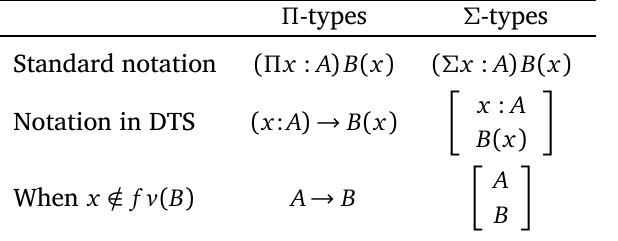
Figure 1: Notation for (cid:5) -types and (cid:6) -types in DTS ( f v ( B ) means the set of free variables in B